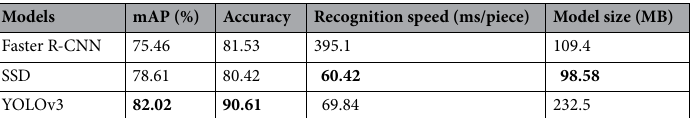
Table 10. Experimental results of Plan B. The bold values are meant to represent the best results obtained under the corresponding metric.